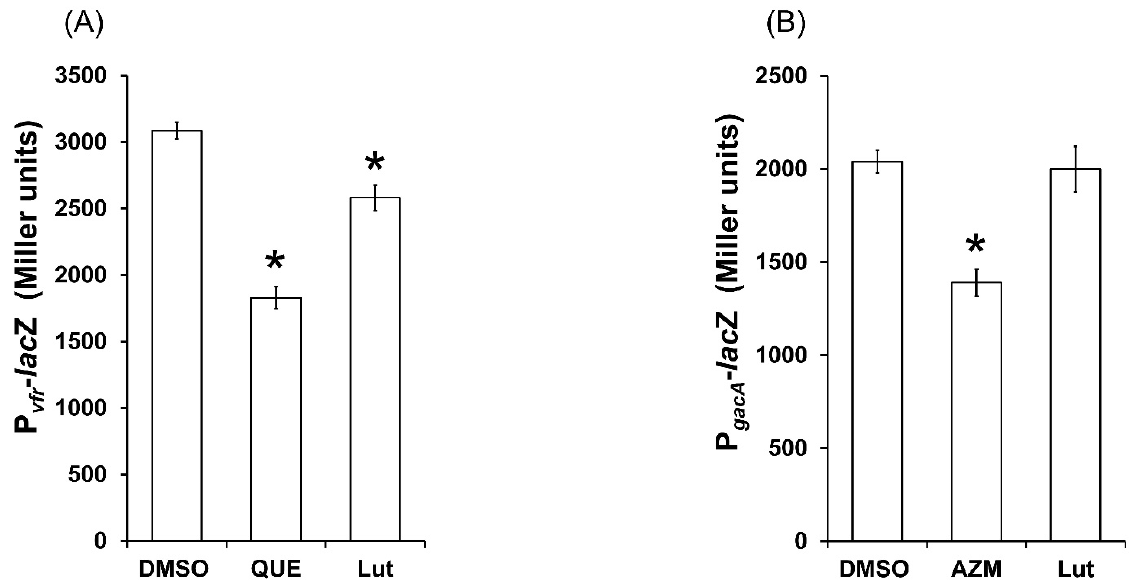
Figure 11. Effect of Lut at 22 µM on the expression of PAO1 global regulator vfr and global activator gacA genes after 18 h of incubation. ( A ) vfr expression in presence of Lut. ( B ) gacA expression in presence of Lut. Gene expression was measured as the β -galactosidase activity of the lacZ gene fusions and expressed in Miller units. Quercetin (QUE) and azithromycin (AZM) were used as vfr and gacA inhibitor control and DMSO as a negative control. Error bars represent SEM and all experiments were performed in quintuplicate with three independent assays; asterisks indicate samples that were significantly different from the DMSO ( p ≤ 0.01).